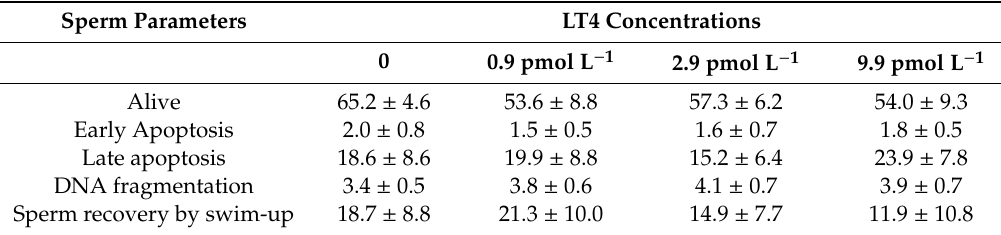
Table 2. Bio-functional sperm parameters and sperm recovery after incubation with increasing concentrations of levothyroxine (LT4)